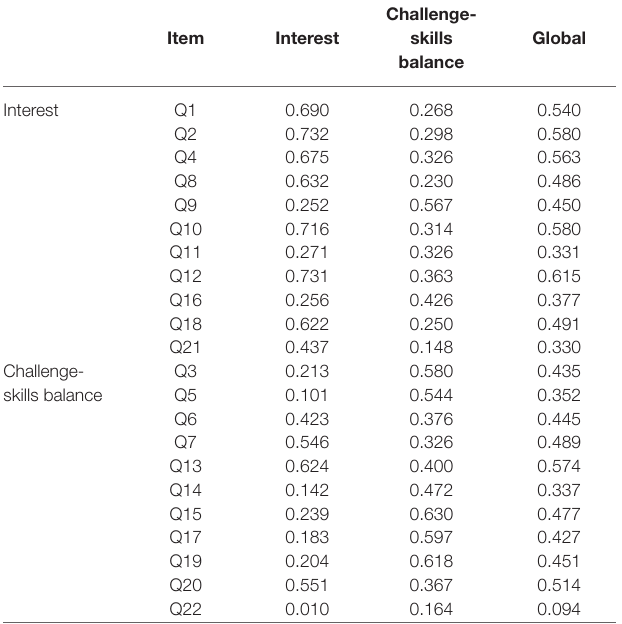
TABLE 1 | Correlation matrix of each item, subscales, and the global scale.